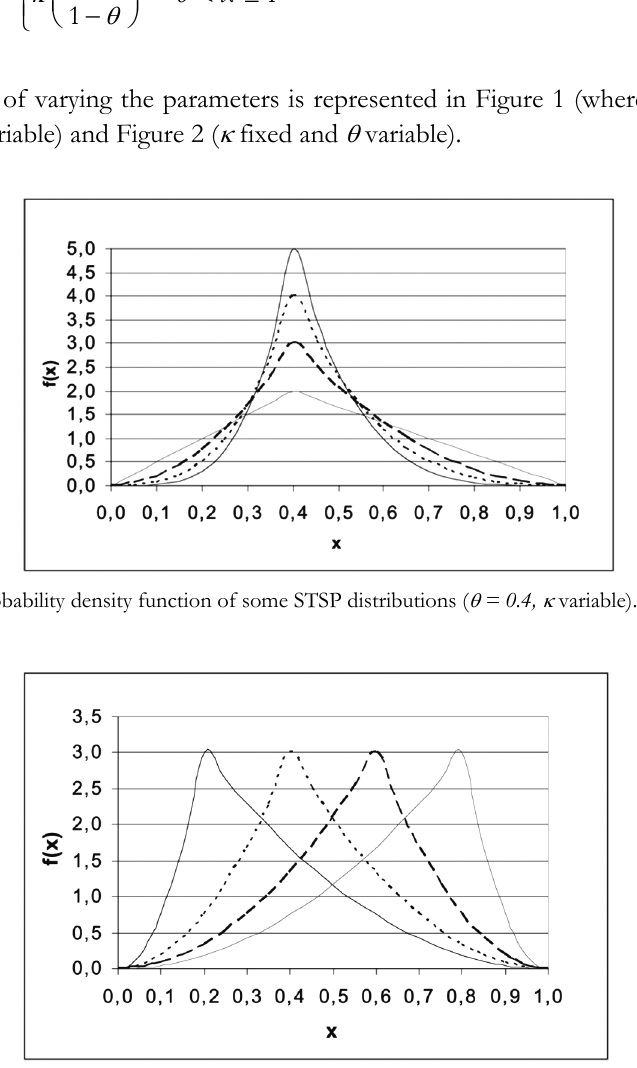
Figure 2 – Probability density function of some STSP distributions ( κ = 3 , θ